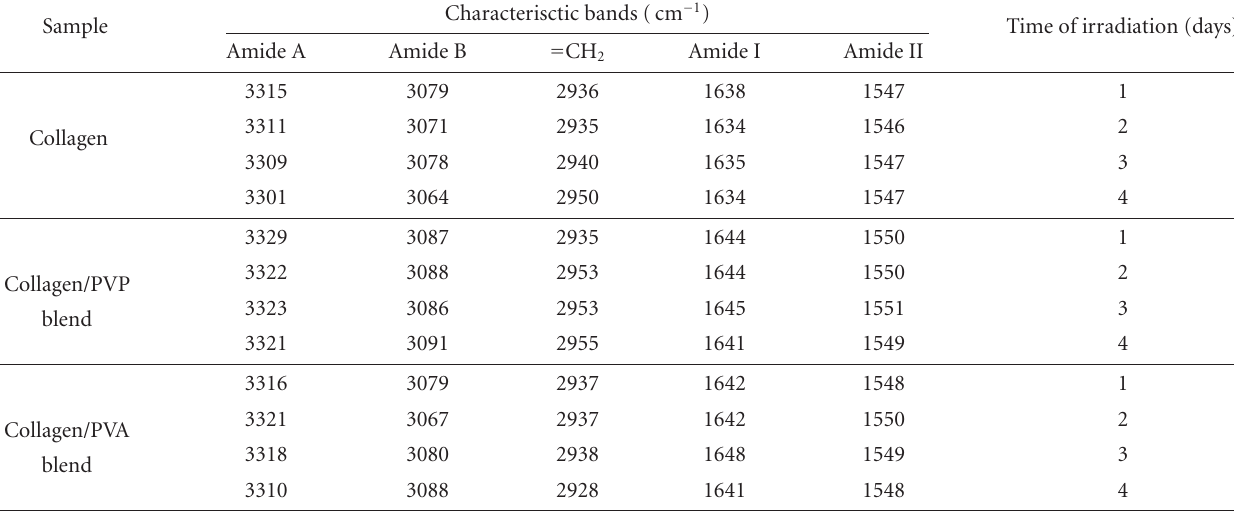
Table 2: The position of Amide bands in FTIR spectra of collagen and collagen-based biomaterials after solar radiation (key to time and dose of solar radiation in Table